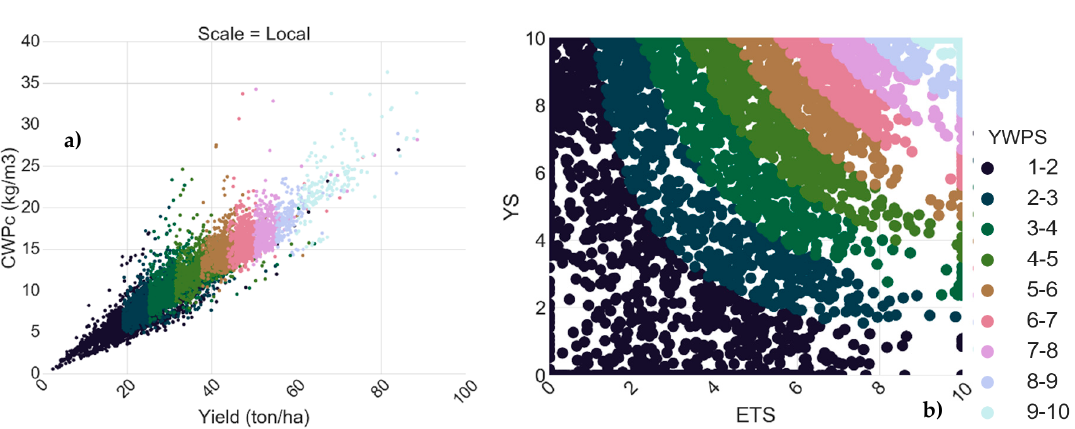
Figure 8 . ( a ) Land and water use productivity score (YWPS) in West Bank, Palestine plotted as a function of yield and CWPc and ( b ) YWPS plotted as a function of YS and ETS (right) for potato in the West Bank.